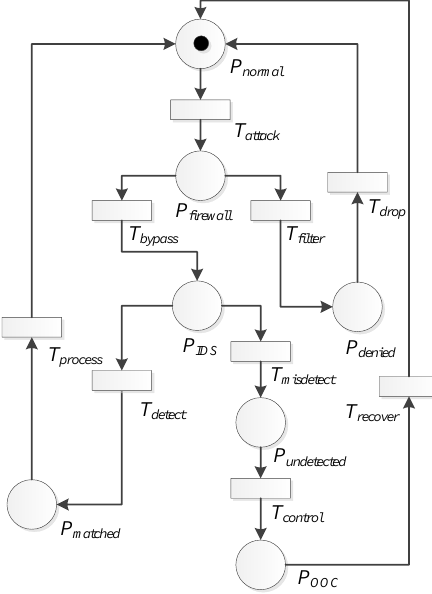
Figure 9. Defense Scenario II: the SPN model.